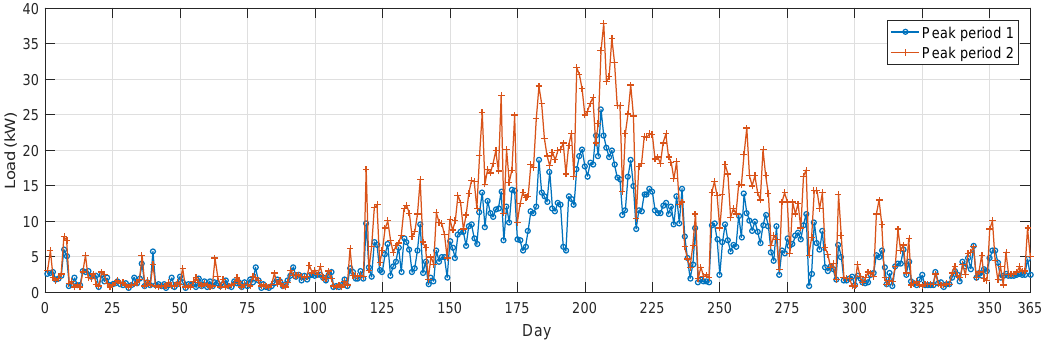
Figure 4. Peak load data of a home during the year of 1 January–31 December 2017